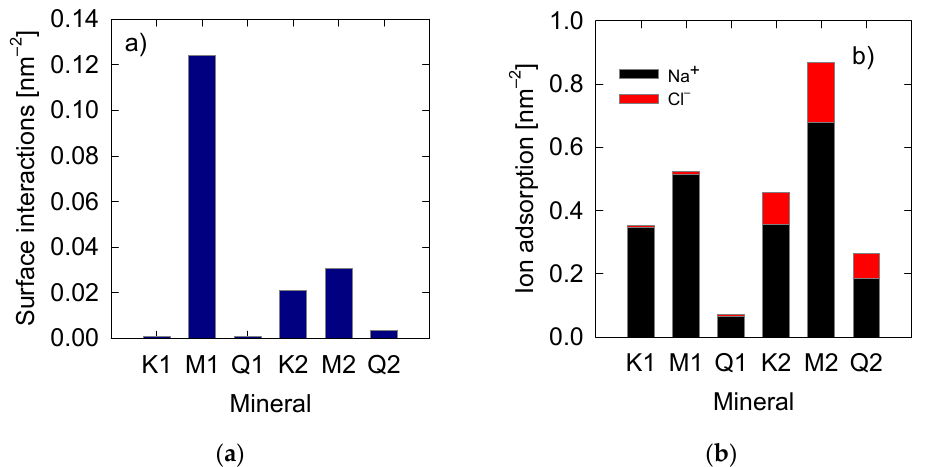
Figure 2. Surface adsorption of ( a ) PAA and ( b ) Na + and Cl − on kaolinite (K), montmorillonite (M) and quartz (Q). K1, M1, and Q1 are at 0.06M salt concentration. K2, M2, and Q2 are at 0.6M salt concentration.